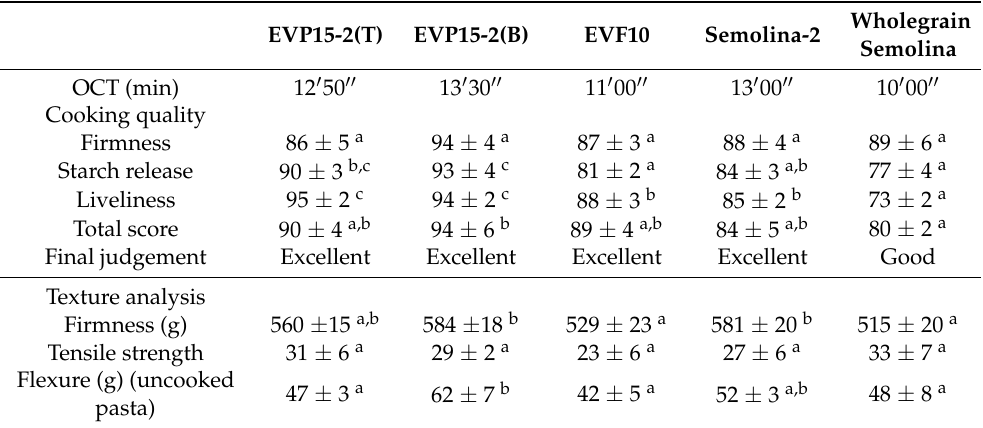
letters in rows indicate statistically significant differences ( p <